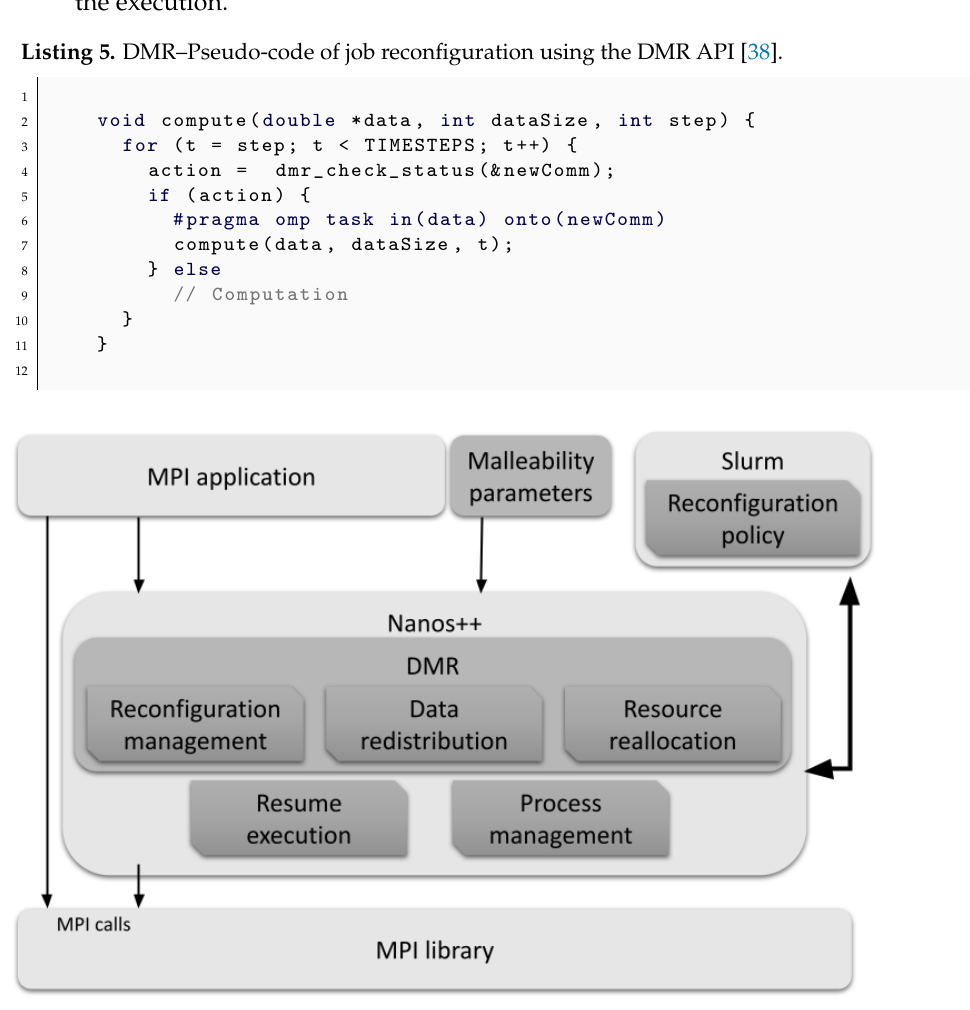
Figure 4. DMR API